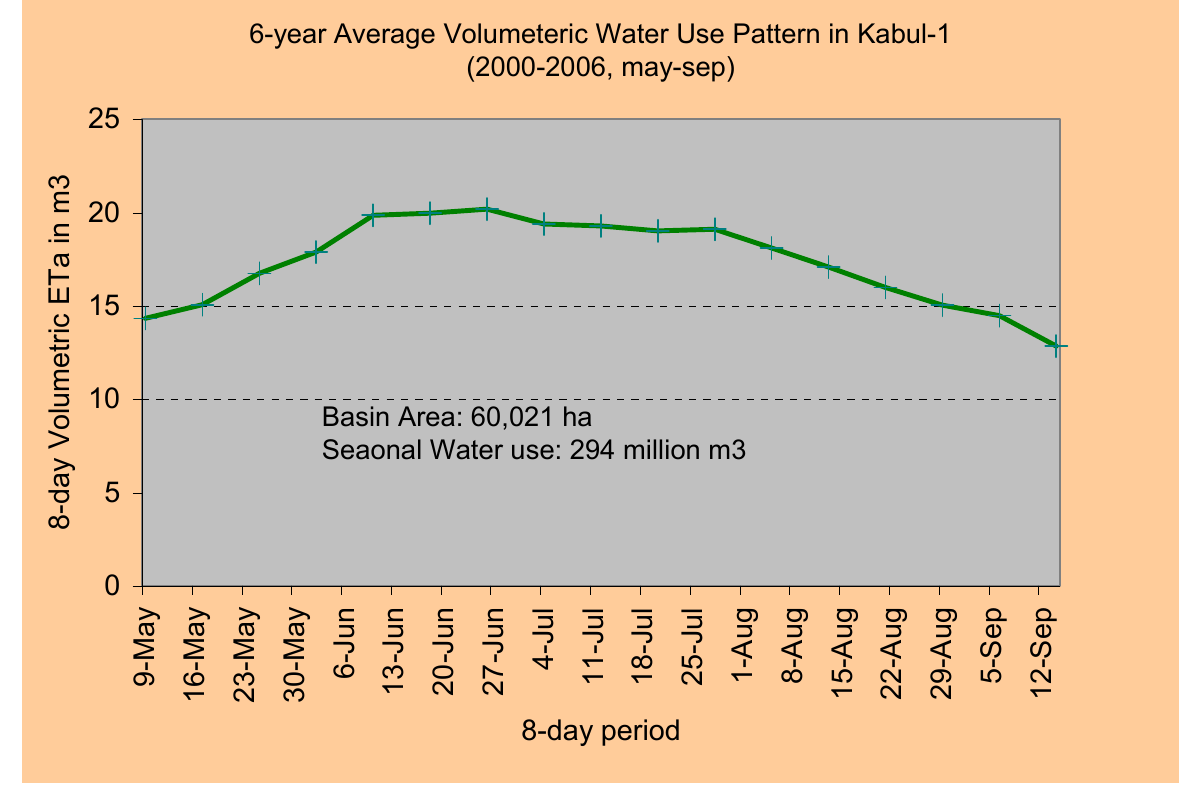
Figure 11. Estimated volumetric water use (ETa, m 3 ) pattern for the Kabul 1 irrigated